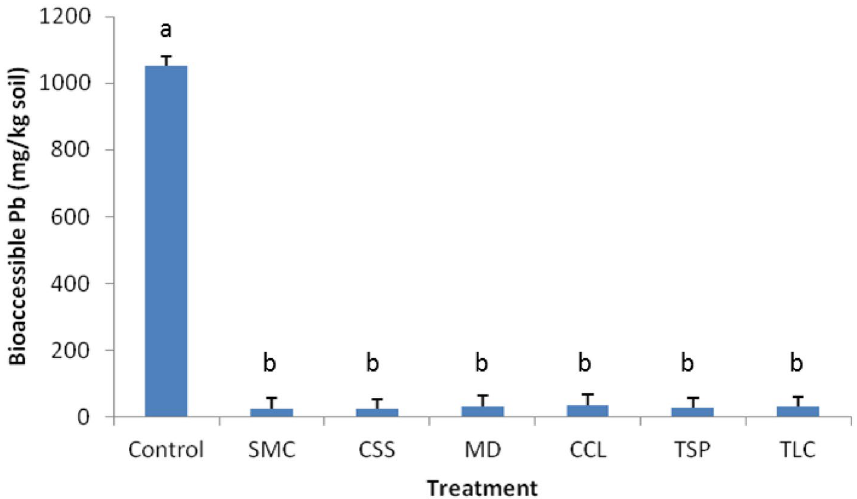
Figure 2. Average of bioaccessible Pb in the amendment-treated and untreated (control) mining wastes during the 8–10 year sampling period post treatment. Vertical bars indicate the standard deviation of measurements, and different letters denote significant difference ( p < 0.05) among